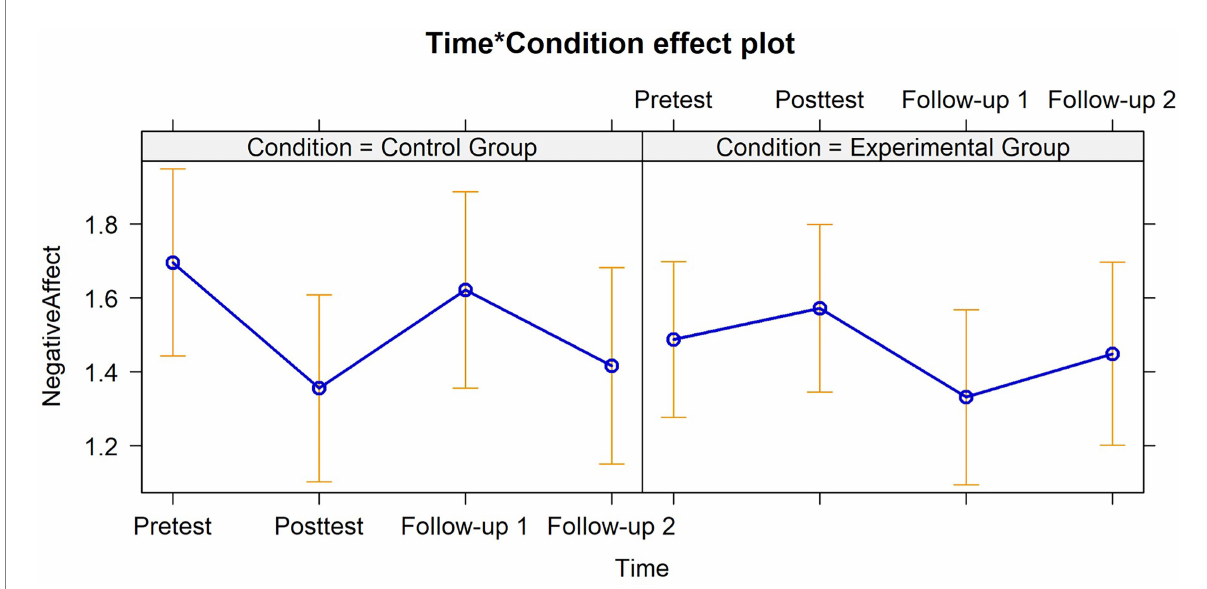
FIGURE 4 Graphical representation of interaction effects (Time*Treatment Condition) on proximal and distal dependent variables – Cluster B. Negative affect depicting a significant effect at posttest ( B = 0.43, SE = 0.20, 95% CI [0.04, 0.82], f 2 =